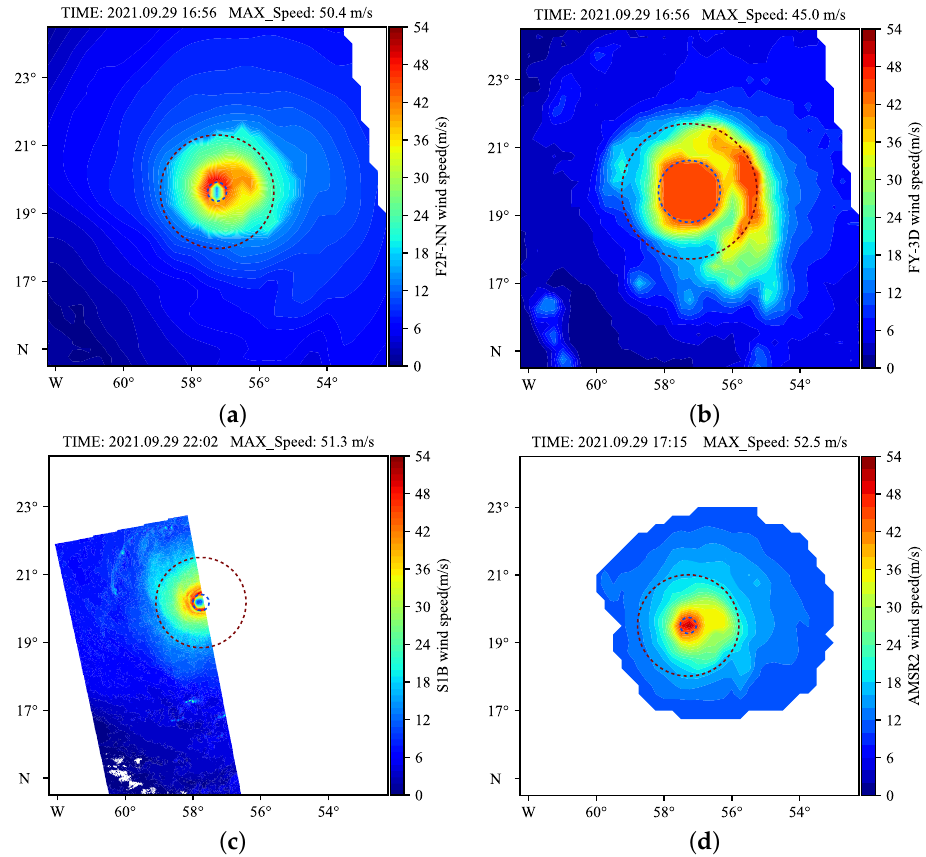
Figure 9. ( a – d ) are descriptions of Hurricane Sam by F2F-NN, FY-3D, S1B, and AMSR2, respectively. IBTrACS data shows that the MAX Speed of Hurricane Sam is 59.2 m/s (true value) at 17:00, and the hurricane wind fields in Table 5 all underestimate the MAX Speed of the hurricane. The MAX Speed of F2F-NN and AMSR2 differs very little from the IBTrACS data ( Bias < 9 m/s). It is worth mentioning that the maximum wind speed of ECMWF is very different from the true value, even reaching 32.2 m/s, which proves that the reanalysis data is not suitable for describing high-speed wind. This is why we chose WindSat data instead of ECMWF data as the wind speed label value for high-speed wind field. The S1B and AMSR2 data perform very well on the RMW metric ( Bias < 2 km). The RMW of F2F-NN is 31.04 km, which is only 3.26 km from the RMW of IBTrACS (27.78 km). F2F-NN is very accurate in describing the regional structure near the hurricane center. In addition, reanalysis data generally amplifies the RMW, while radiometer and SAR data degrade the RMW. The analysis is not meaningful in FY-3D data due to wind saturation. The difference between the R34 Mean of the F2F-NN data and the true value (163.21 km) is 20.98 km, and the 34-knot wind speed distribution range is very close to the true wind field. The performance of AMSR2 is the best, which further illustrates the feasibility of using AMSR2 data to perform the overall accuracy test of the F2F-NN wind field in the previous paper. The R34 Mean of FY-3D is much larger than the true value. To sum up, the F2F-NN wind field performs well in all evaluation metrics and has a complete wind field structure and obvious continuity characteristics. In addition, the F2F-NN has a strong ability to retrieve high-speed wind